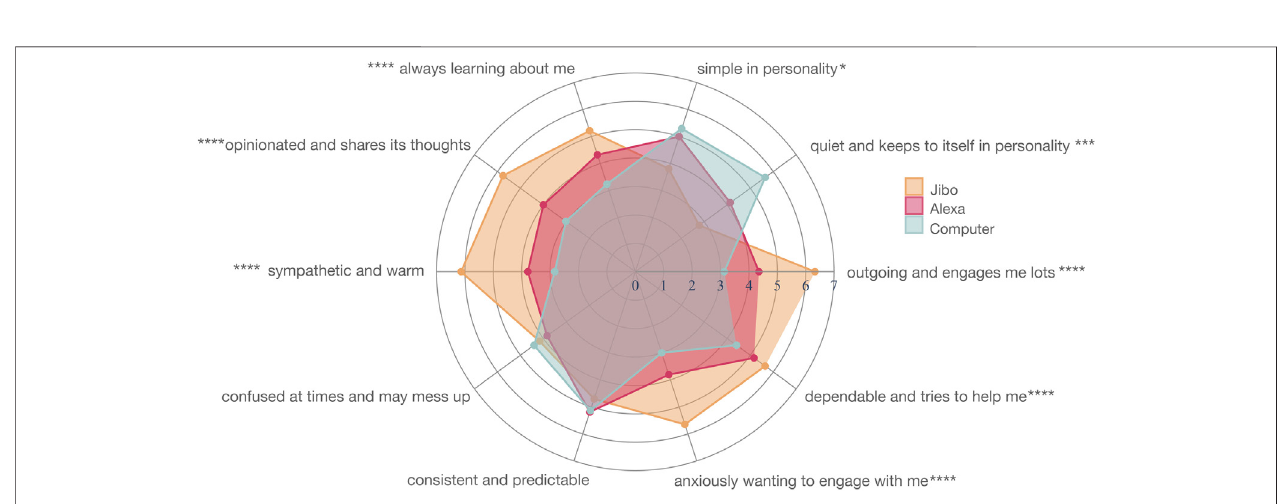
FIGURE 11 | Personality mapping for Jibo (orange), Alexa (red), and Computer (blue) in Study 3